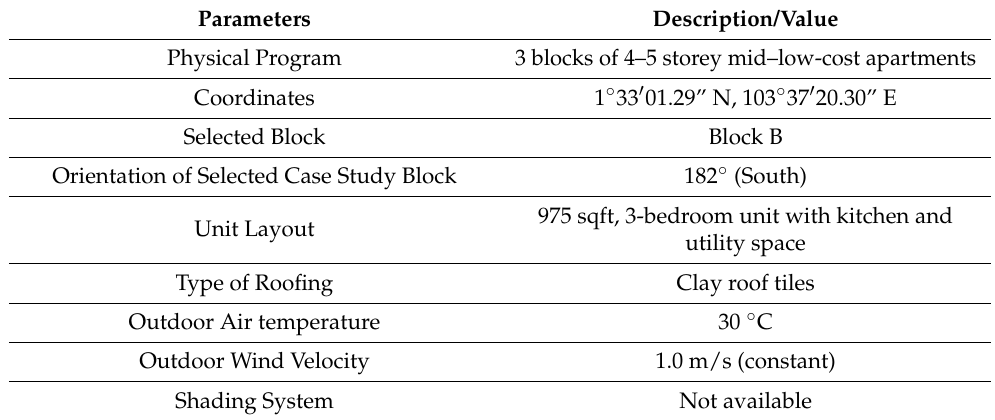
Table 1. Case study